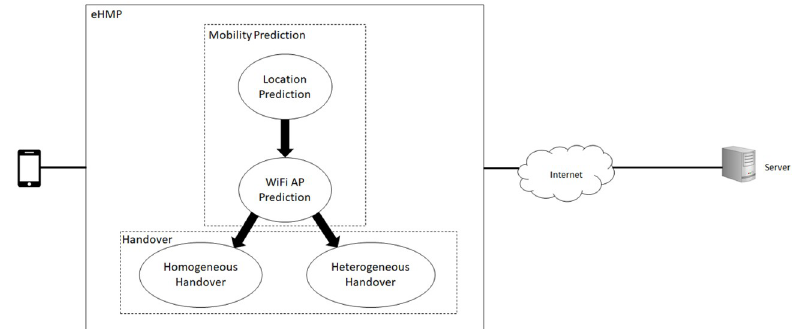
Fig 10. Enhanced handover mechanism using mobility prediction.